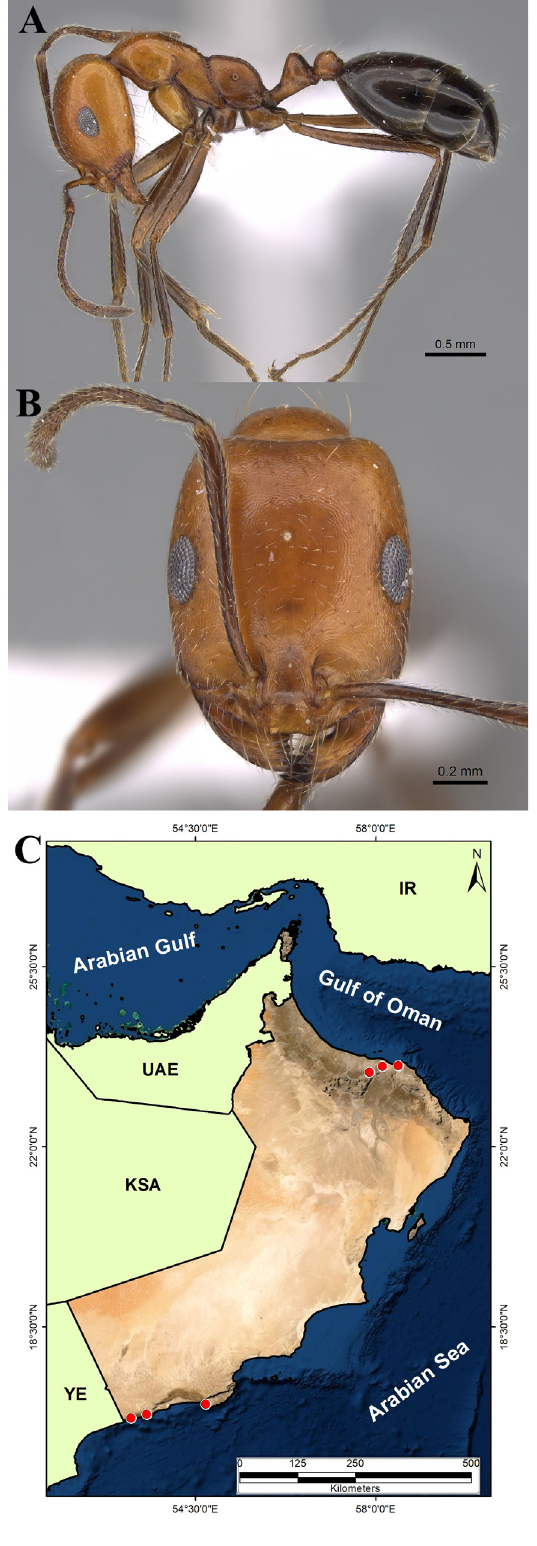
Fig. 41. Monomorium niloticum Emery, 1881, worker (CASENT0922859, AntWeb.org (Michele Esposito)). A . Body in profile. B . Head in full-face view. C . Distribution